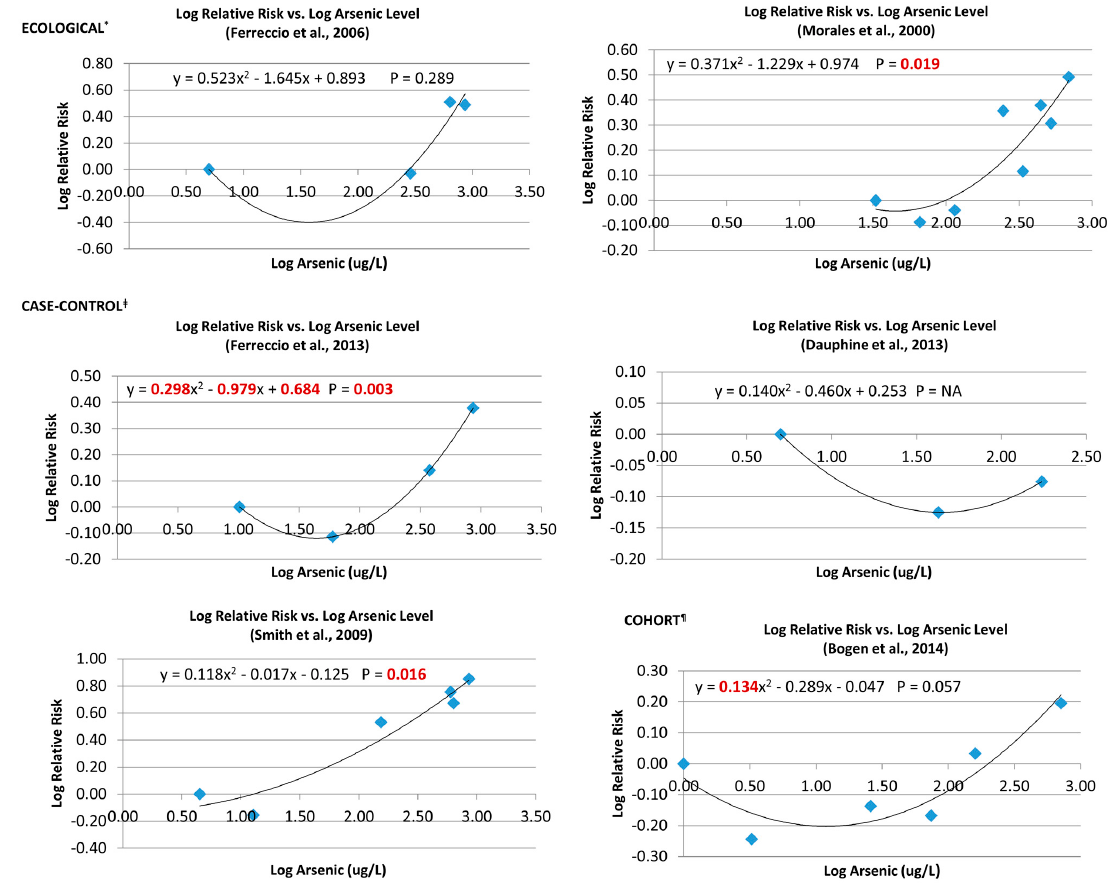
Figure 1. Log-Log plots of individual studies. * Ecological Studies: Ferrecio et al. , 2006 [38] (Chile), Morales et al. , 2000 [40] (SW Taiwan); ǂ Case-Control Studies: Ferrecio et al. , 2013 [39] (Chile), Dauphine et al. , 2013 [41] (USA), Smith et al. , 2009 [20] (Chile), Cohort Study: Bogen et al. , 2014 [21] (NE Taiwan). Note: log 1 = 0; log 10 = 1; log 100 = 2.